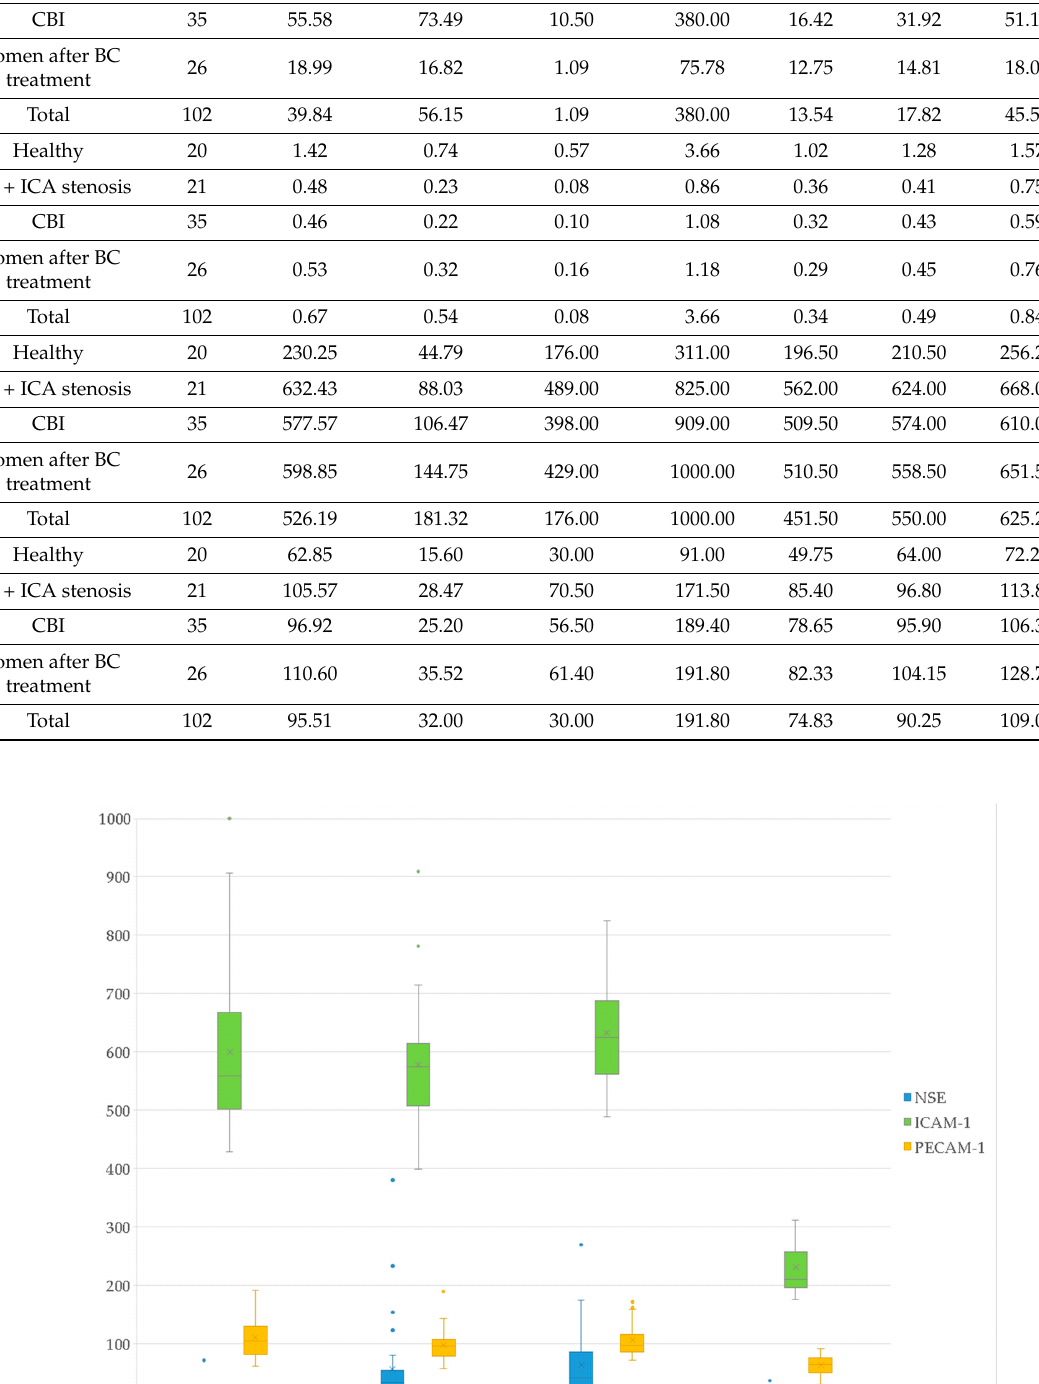
Table 4. Serum biomarker levels in the study groups (n = 102).